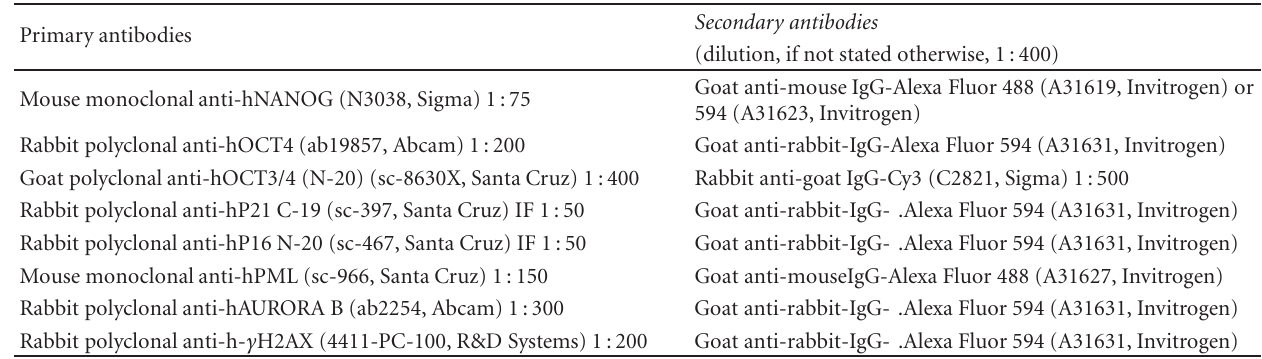
Primary antibodies